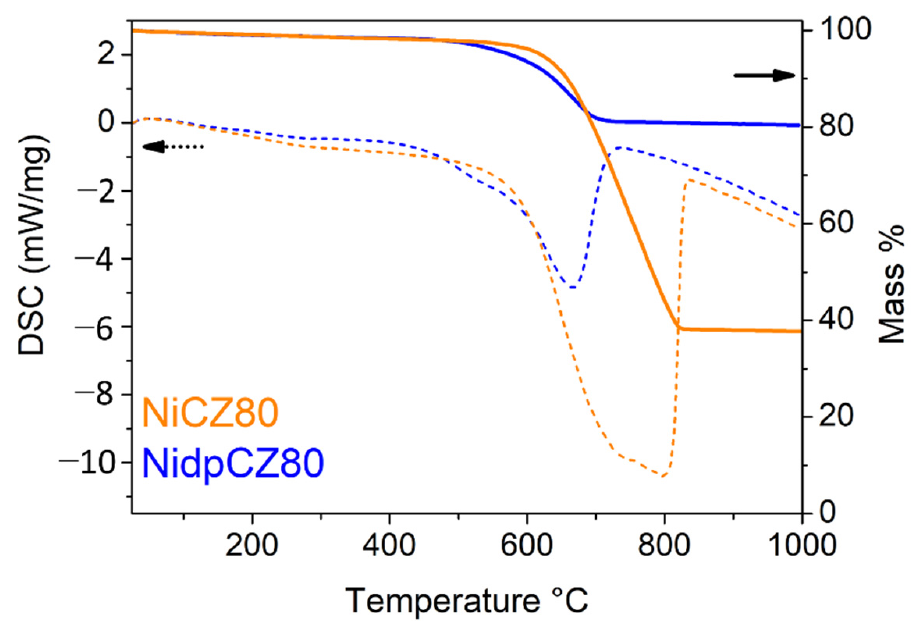
Figure 15. TGA ‐ DSC profiles of NidpCZ80 and NiCZ80 catalysts after endurance test. Figure 15. TGA-DSC profiles of NidpCZ80 and NiCZ80 catalysts after endurance